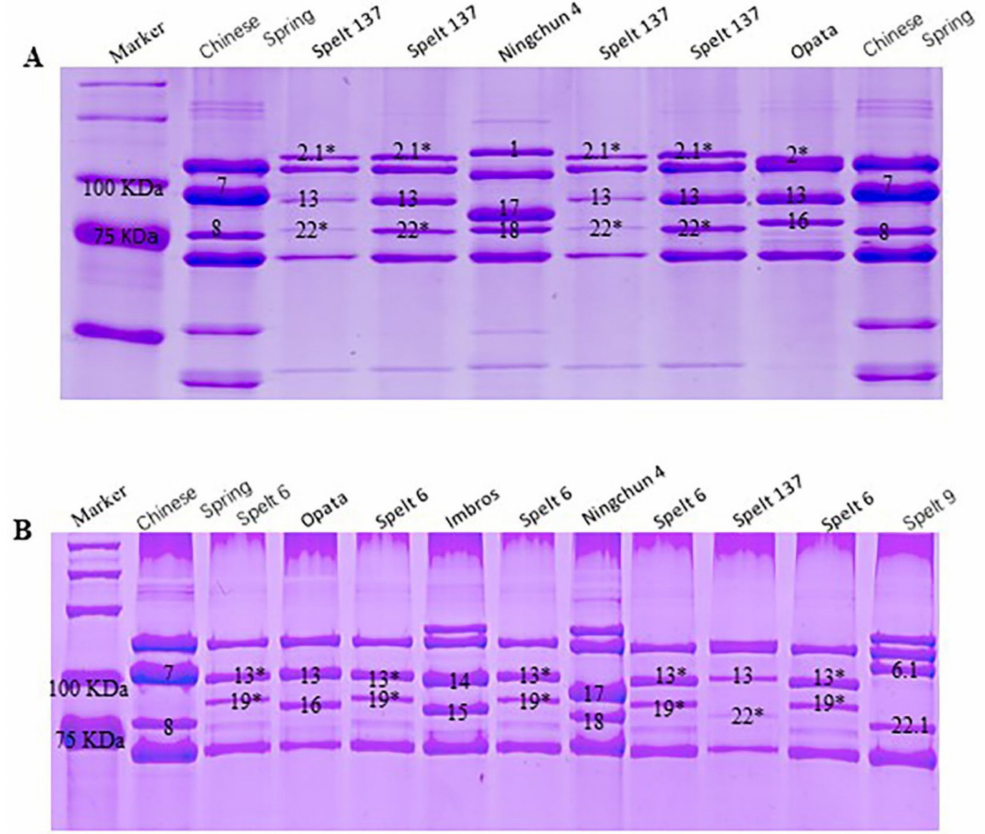
Figure 1. Identification of HMW-GS in European spelt wheat varieties Spelt 137 ( A ) and Spelt 6 ( B ) by SDS-PAGE. The HMW-GS in wheat is marked on the gel image with numbers or numbers with